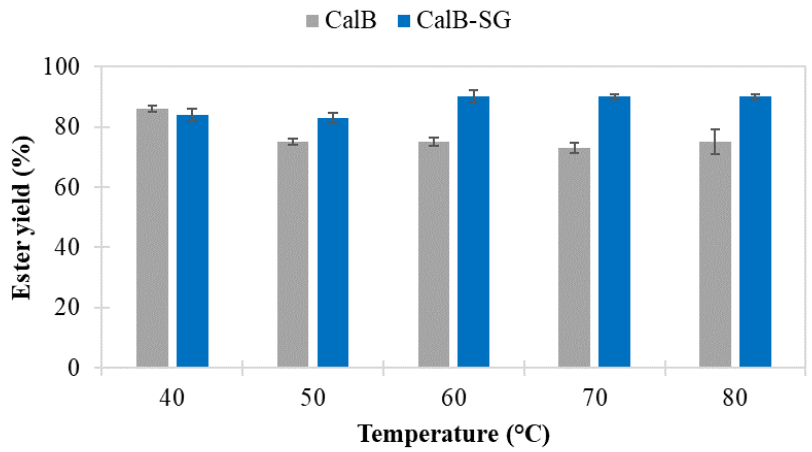
Figure 4. Influence of the preincubation of Candida antarctica lipase B (CalB—native lipase; CalB- SG—sol-gel-entrapped CalB lipase) at different temperatures on the ester synthesis yield of n-amyl caproate in a solventless medium.